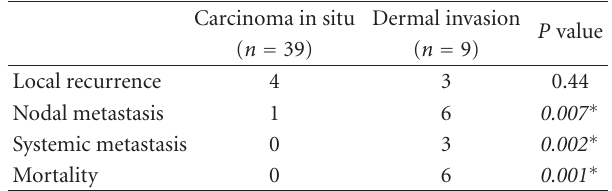
Carcinoma in situ Dermal invasion P